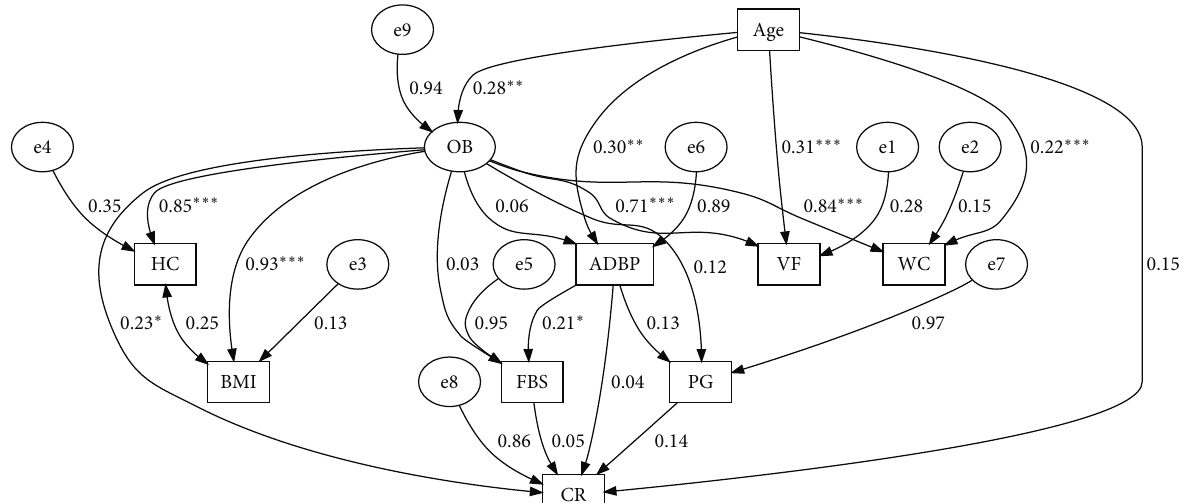
Figure 4: Structural equation modelling assessing the effect of manifest blood pressure (average diastolic blood pressure) on type 2 diabetes and coronary risk (Model